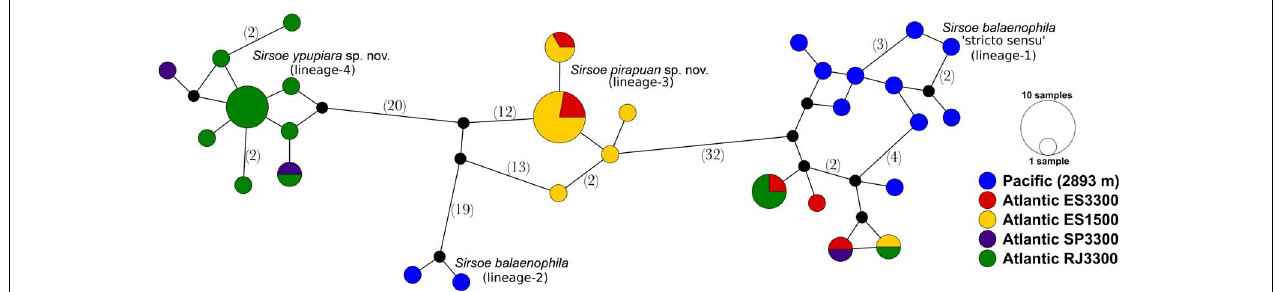
FIGURE 4 | Haplotype network of Sirsoe balaenophila species complex based on TCS analyses (Clement et al., 2000). The network was produced in PopART (Leigh and Bryant, 2015). Numbers in parentheses are numbers of substitution sites between haplotypes. Only one substitution was omitted. Black circle represents a missing inferred